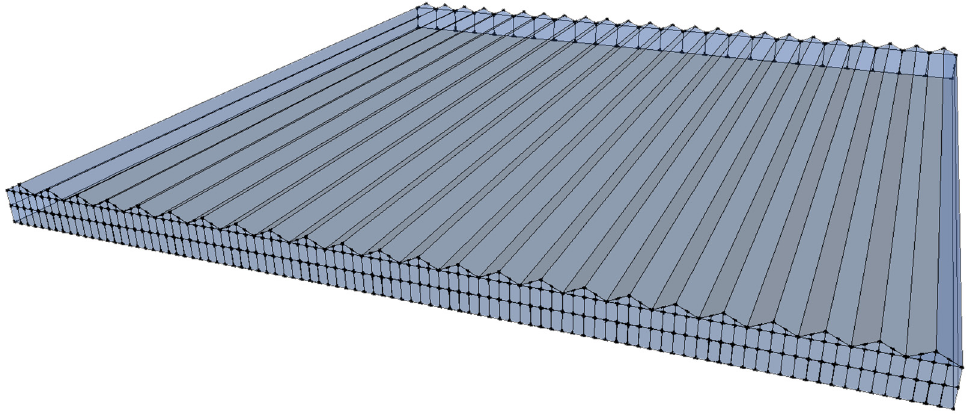
Figure 1. Simulation Model [6]. Table 3. The iron frame physical properties applied to the simulation.